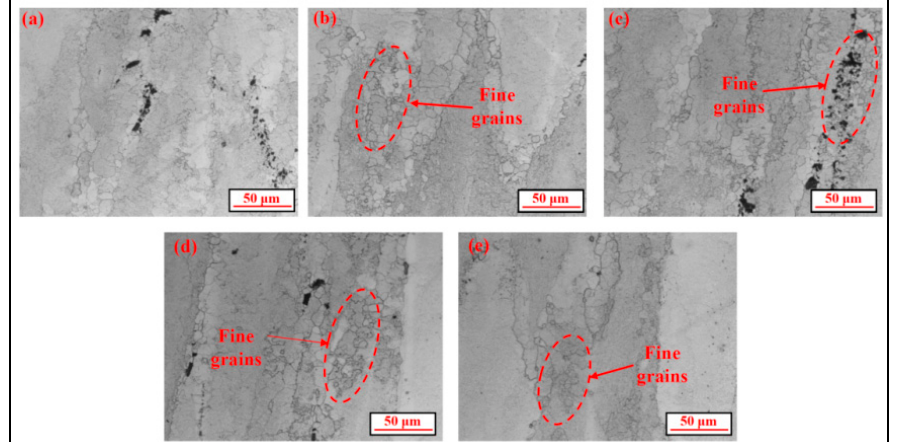
Figure 5. 7B04 aluminum alloy phase structure. ( a ) Al matrix; ( b ) Al-1 enhancement zone; ( c ) Al-2 enhancement zone; ( d ) Al-3 enhancement zone; ( e ) Al-4 enhancement zone.